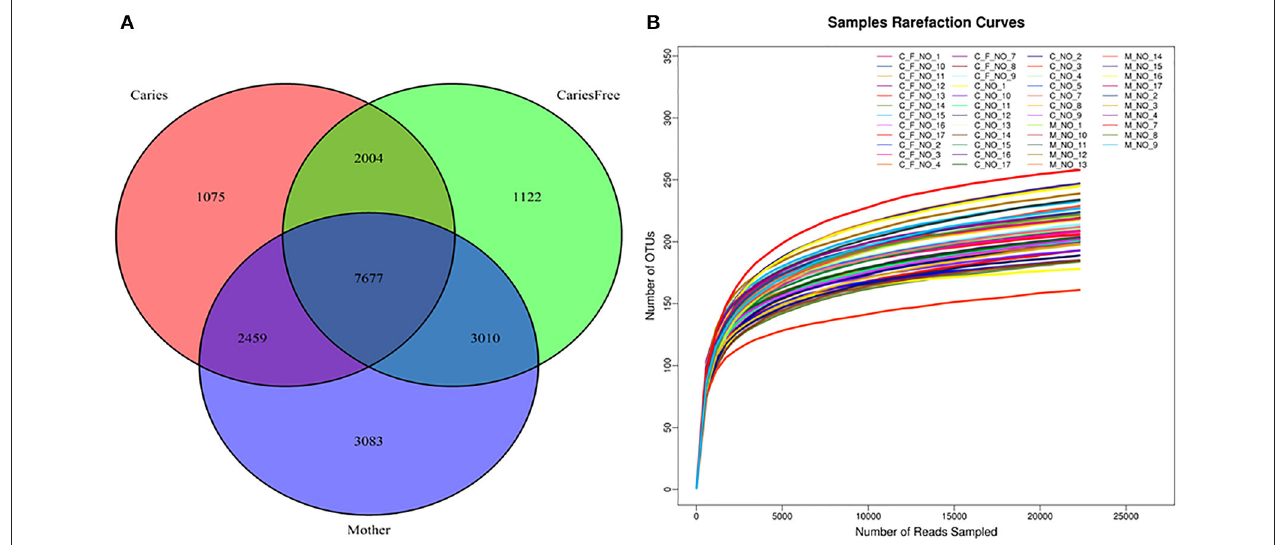
FIGURE 1 | (A) Venn Diagram represented number of OTUs among three groups after rarefaction to 22,841 sequences per individual. Red circle showed the Caries group; mother group was the blue circle; Green circle represented the caries-free group. The numbers in each circle showed the number of OTUs were found in each group, and overlap represented the shared OTUs in different groups. (B) Rarefaction curves for individuals in caries, caries-free and mother group. Rarefaction curves generated from the phylogenic distances showed that the sequencing depth of the samples in our study was enough to proceed with the next step in the